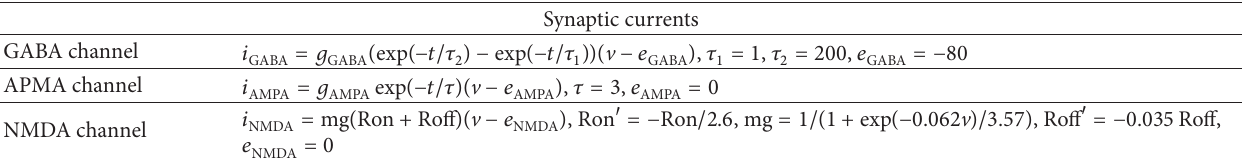
Table 2: Equations and some parameters of synaptic